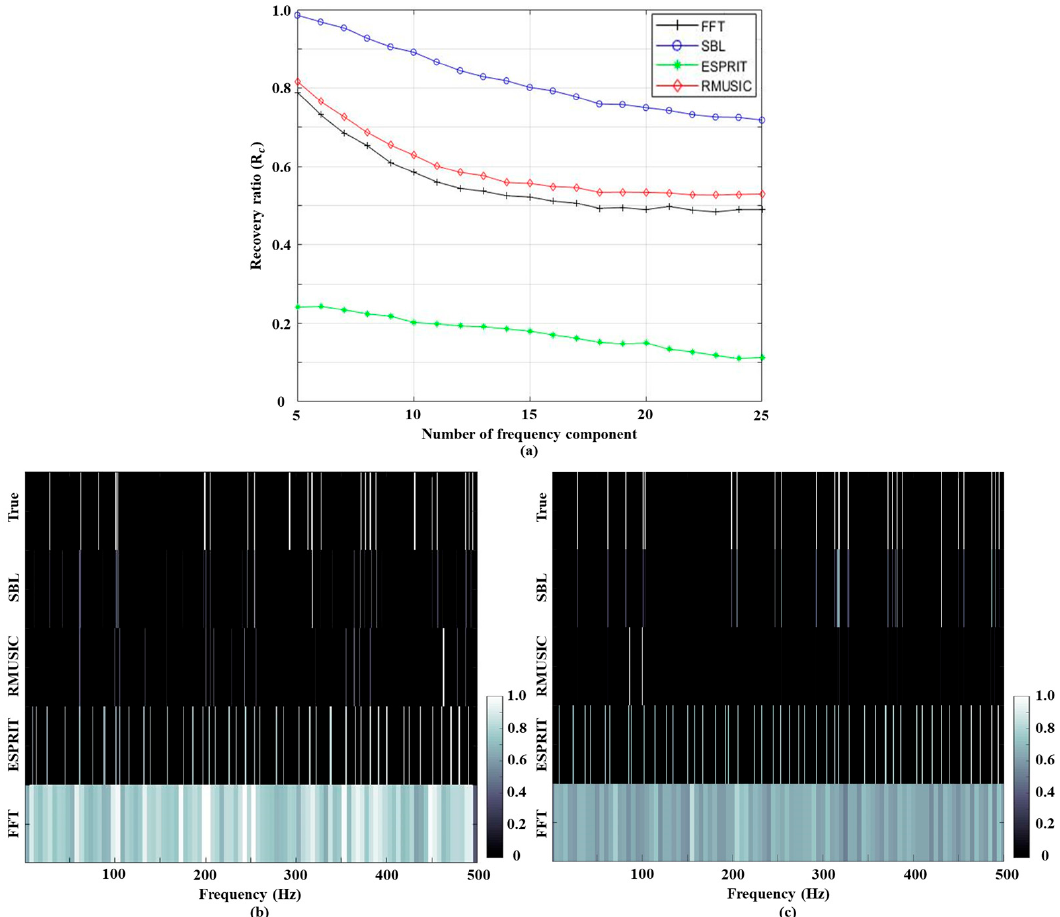
Figure 3. ( a ) The recovery ratios for FFT, SBL, ESPRIT, and RMUSIC according to the frequency component numbers. SNRs for the simulations are fixed at − 15 dB; ( b ) the detection results for data including 25 frequency components. Signal length and measurement number are 0.2 s and 25, respectively; ( c ) the detection results for data including 25 frequency components. The signal length and measurement number increase to 0.5 s and 50, respectively, and they improve the SBL performance noticeably.